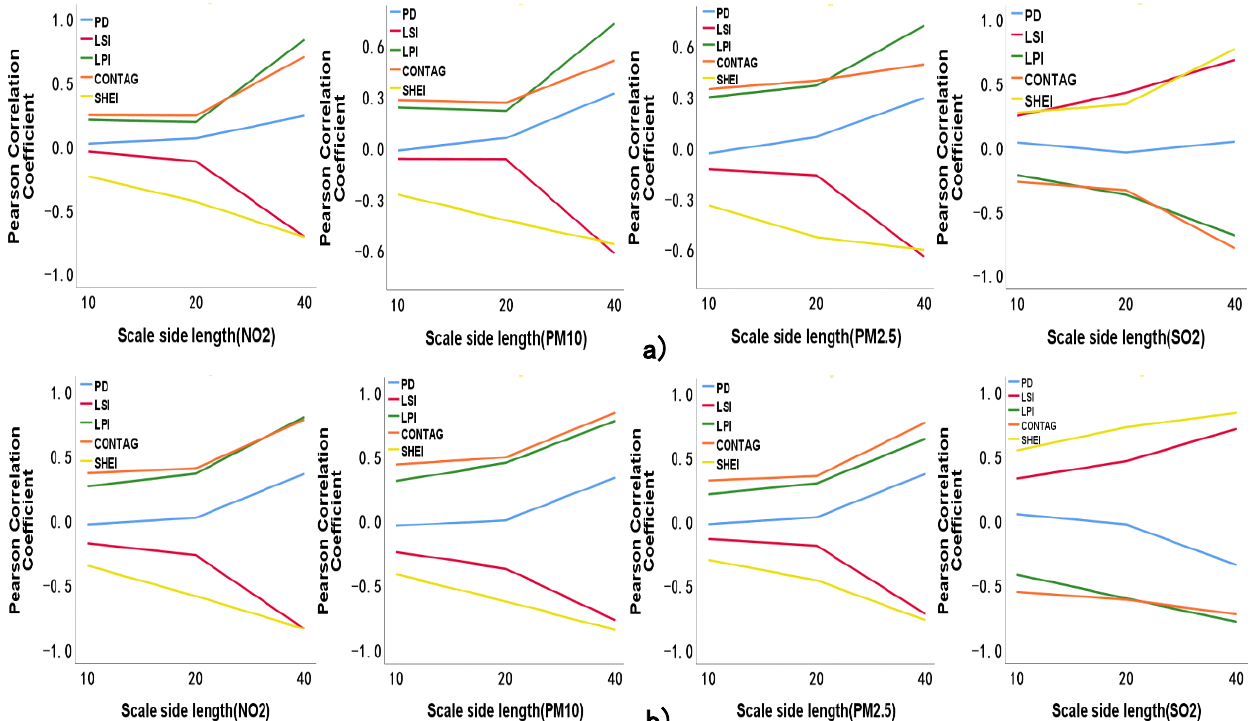
Figure 5. Correlation coefficients between the landscape-level landscape pattern metrics and the concentrations of the pollutants and their variation with the landscape scale ( a ). 2015; ( b ). 2018.